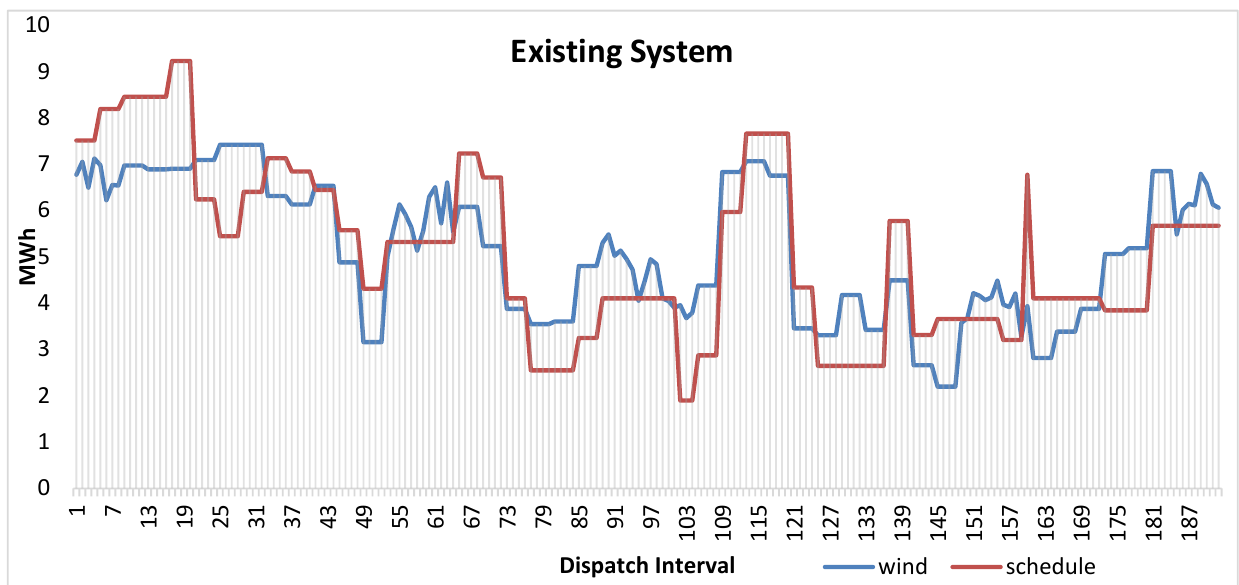
Figure 2. Output and schedule of the wind farm on a particular day.